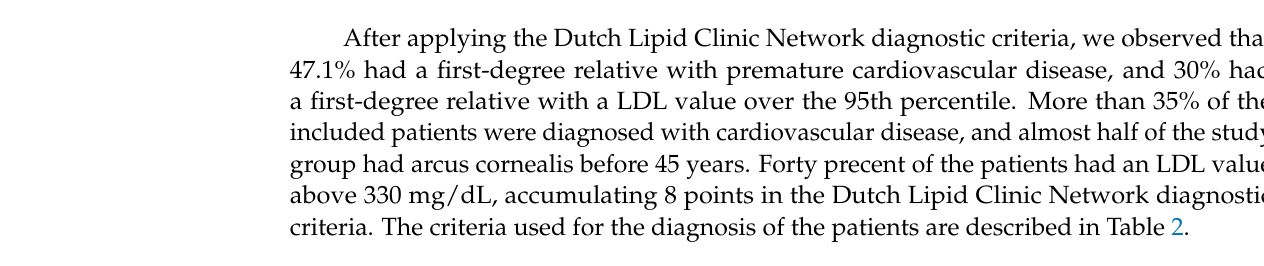
Table 2. Dutch Lipid Clinic Network diagnostic criteria applied to the studied